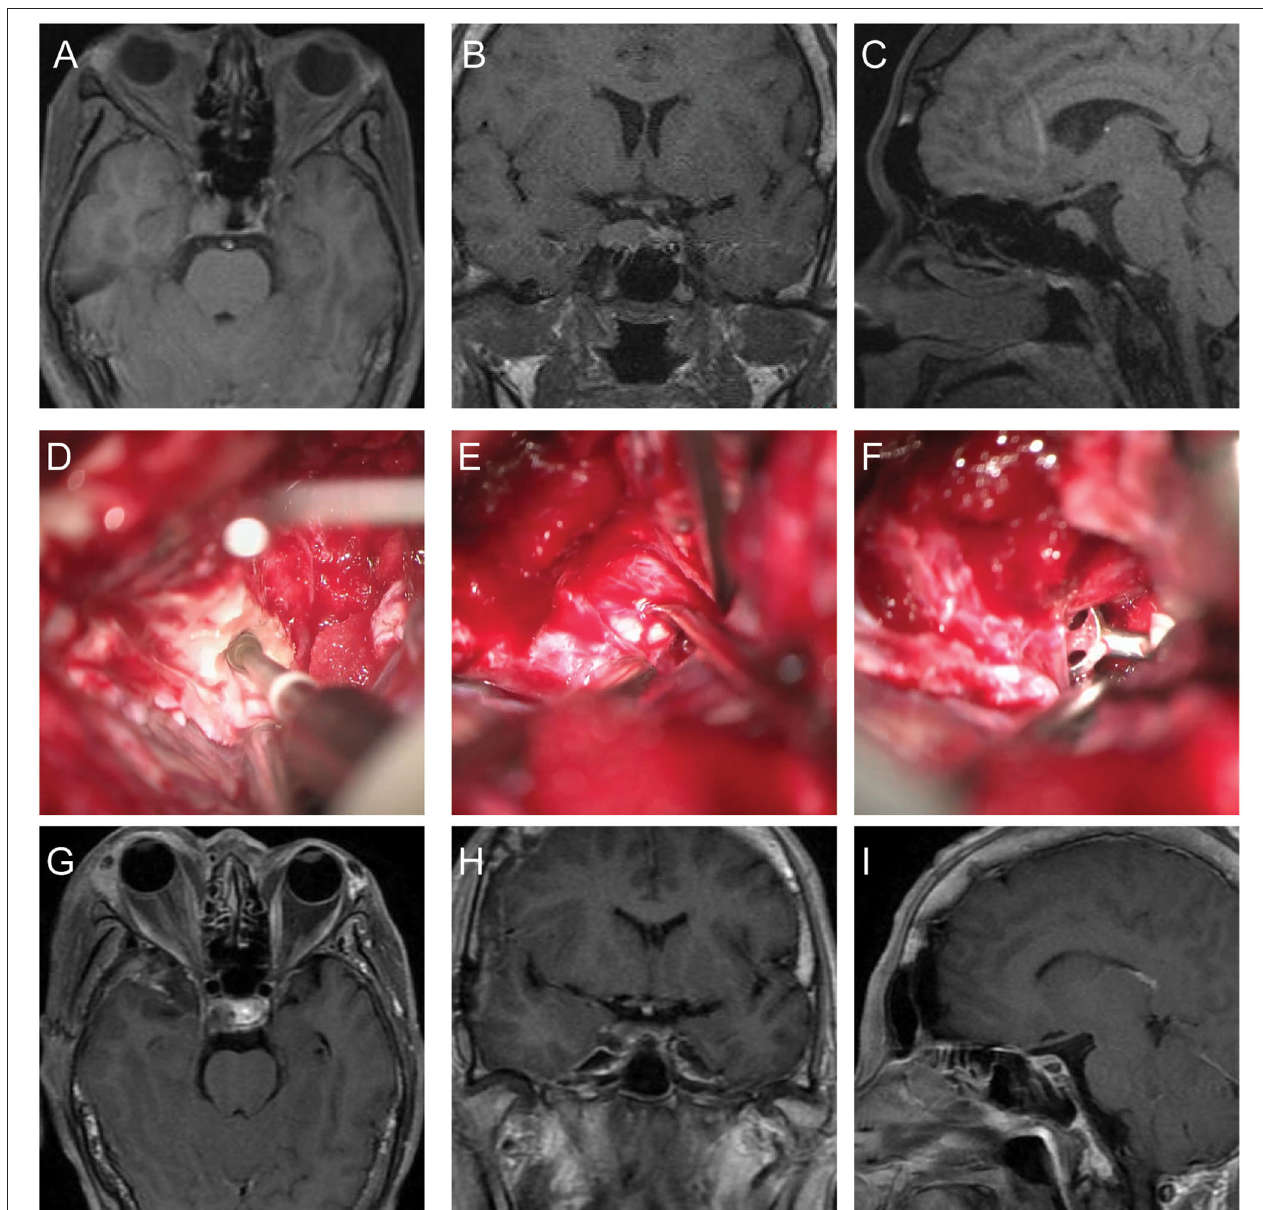
FIGURE 2 | The preoperative and follow-up MRI imaging and intraoperative photography of case 2. (A–C) Preoperative MRI showed the tumor located on the right side of sella and invaded the post-superior part of the right CS. (D) Drilling the ACP extradurally under microscope. (E) Exposure of tumor through the Parkinson’s triangle. (F) Removal of the tumor using microcurette. (G–I) Follow-up MRI showed the original tumor was completely resected without signs of residue or recurrence.